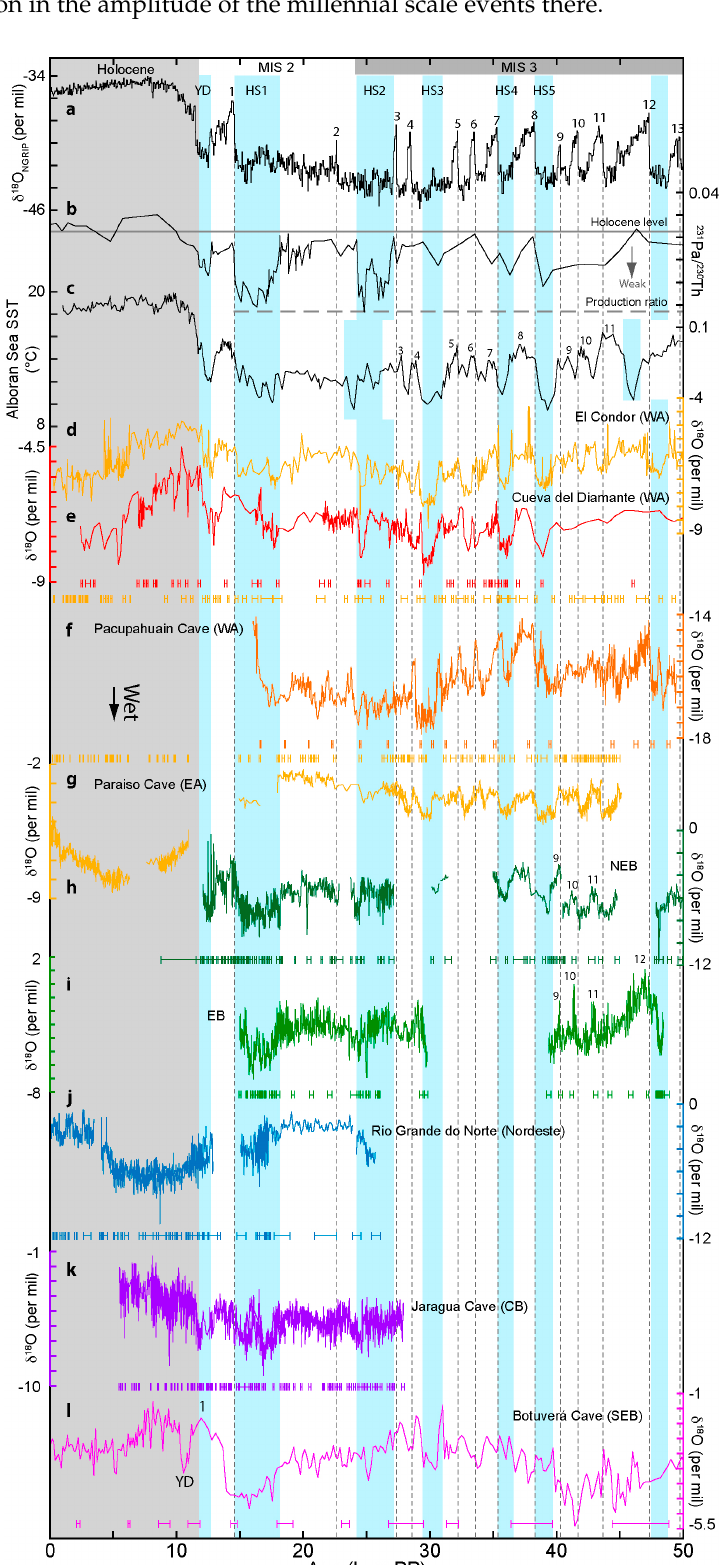
Figure 6. Millennial-scale changes in South American speleothems during the last 50 kyrs reveal coherent changes in rainfall associated with variations in the SAMS activity. ( a ) North GRIP δ 18 O